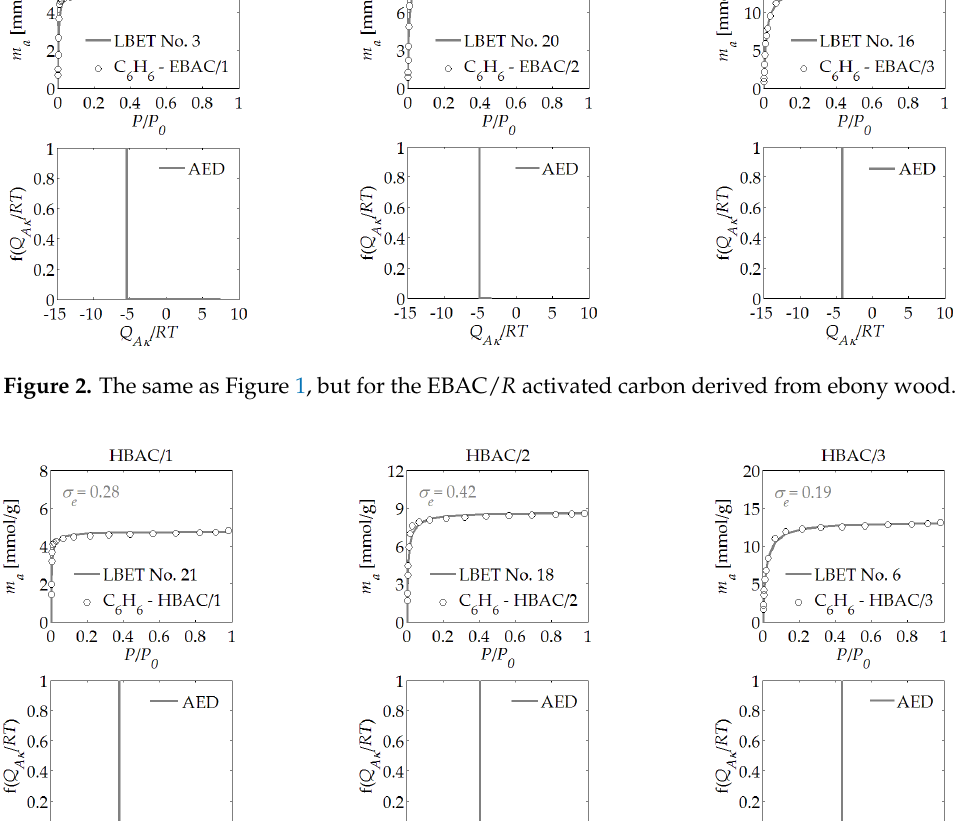
Figure 3. The same as Figure 1, but for the HBAC/ R activated carbons derived from hornbeam wood.